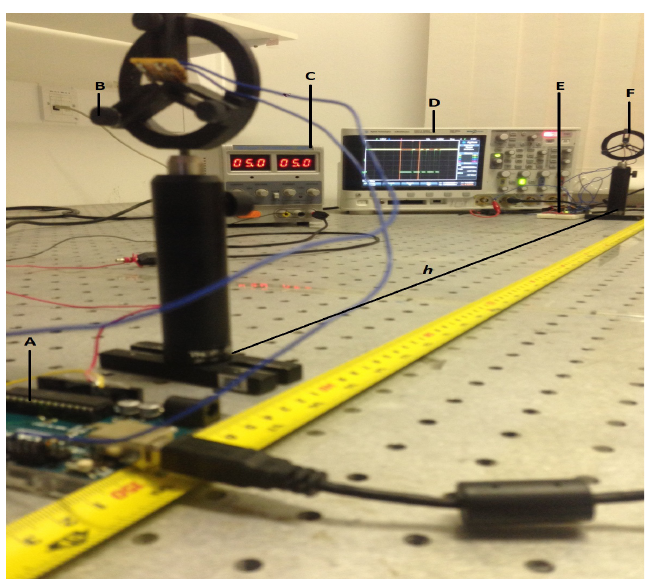
Figure 6. Experimental setup for noise determination. A : Transmitter electronic module, B : Transmitter LED on stand, C : Power supply unit, D : Oscilloscope for measurement, E : Receiver electronics module, F : Receiver PD on